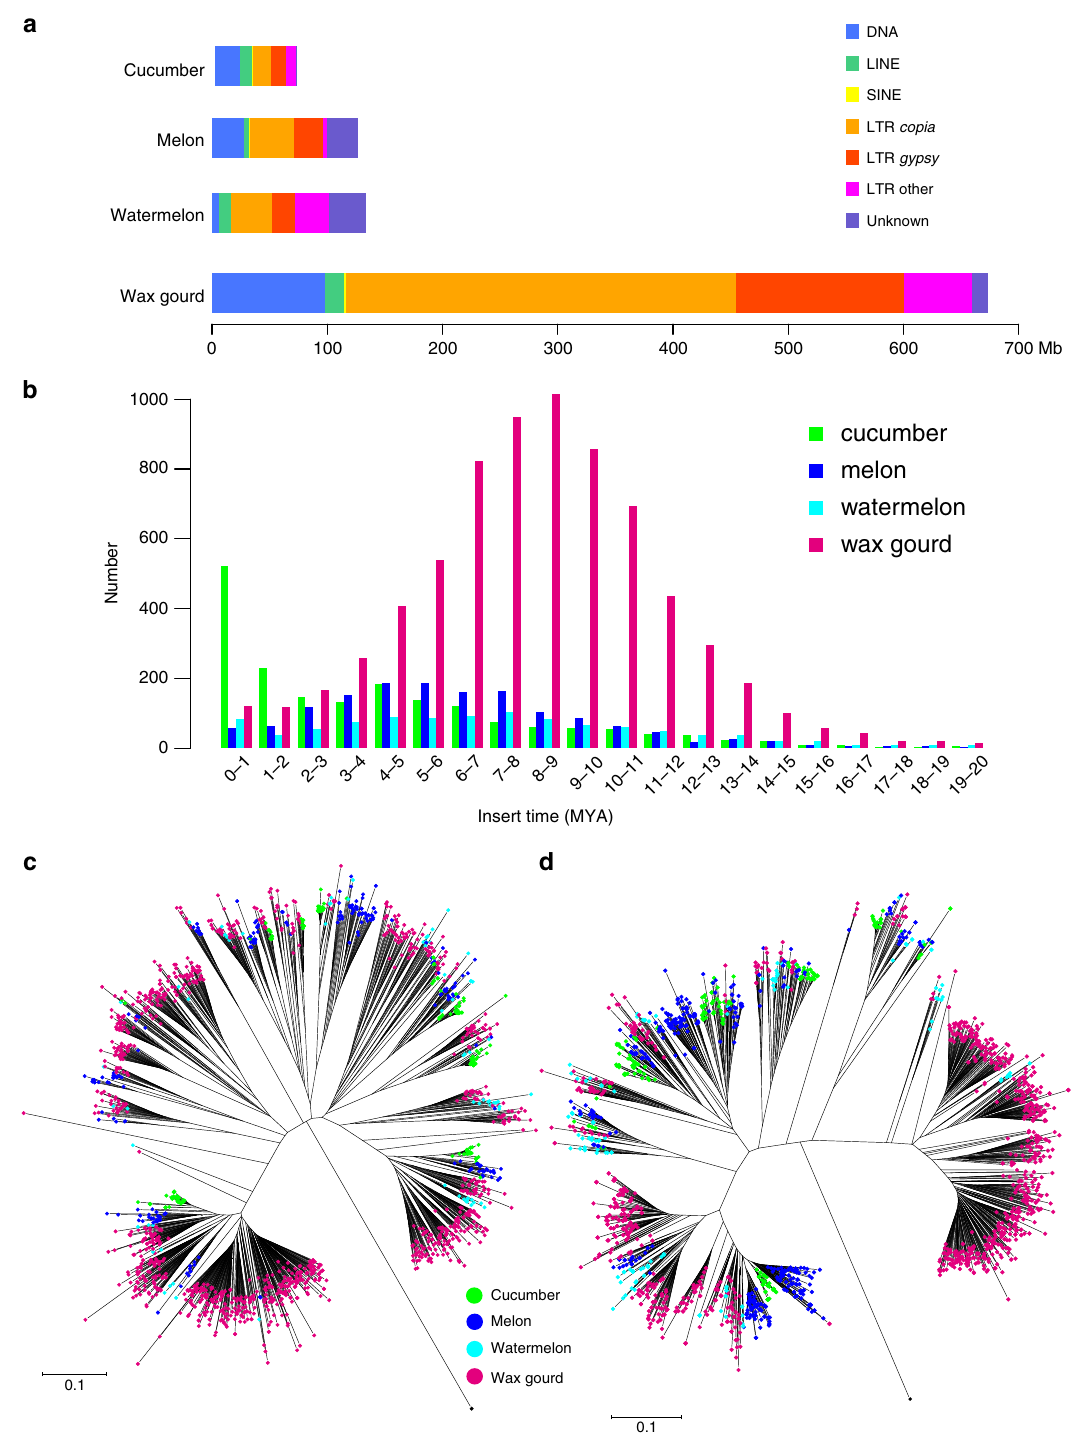
Fig. 3 Expansion of repeats in wax gourd genome. a Transposable elements content in cucumber, melon, watermelon, and wax gourd genomes. b Distribution of insertion times for LTR retrotransposons in cucumber, melon, watermelon, and wax gourd. Phylogenetic relationships of Copia ( c ) and Gypsy ( d ) retrotransposons across cucumber, melon, watermelon, and wax gourd. Source data are provided as a Source Data fi